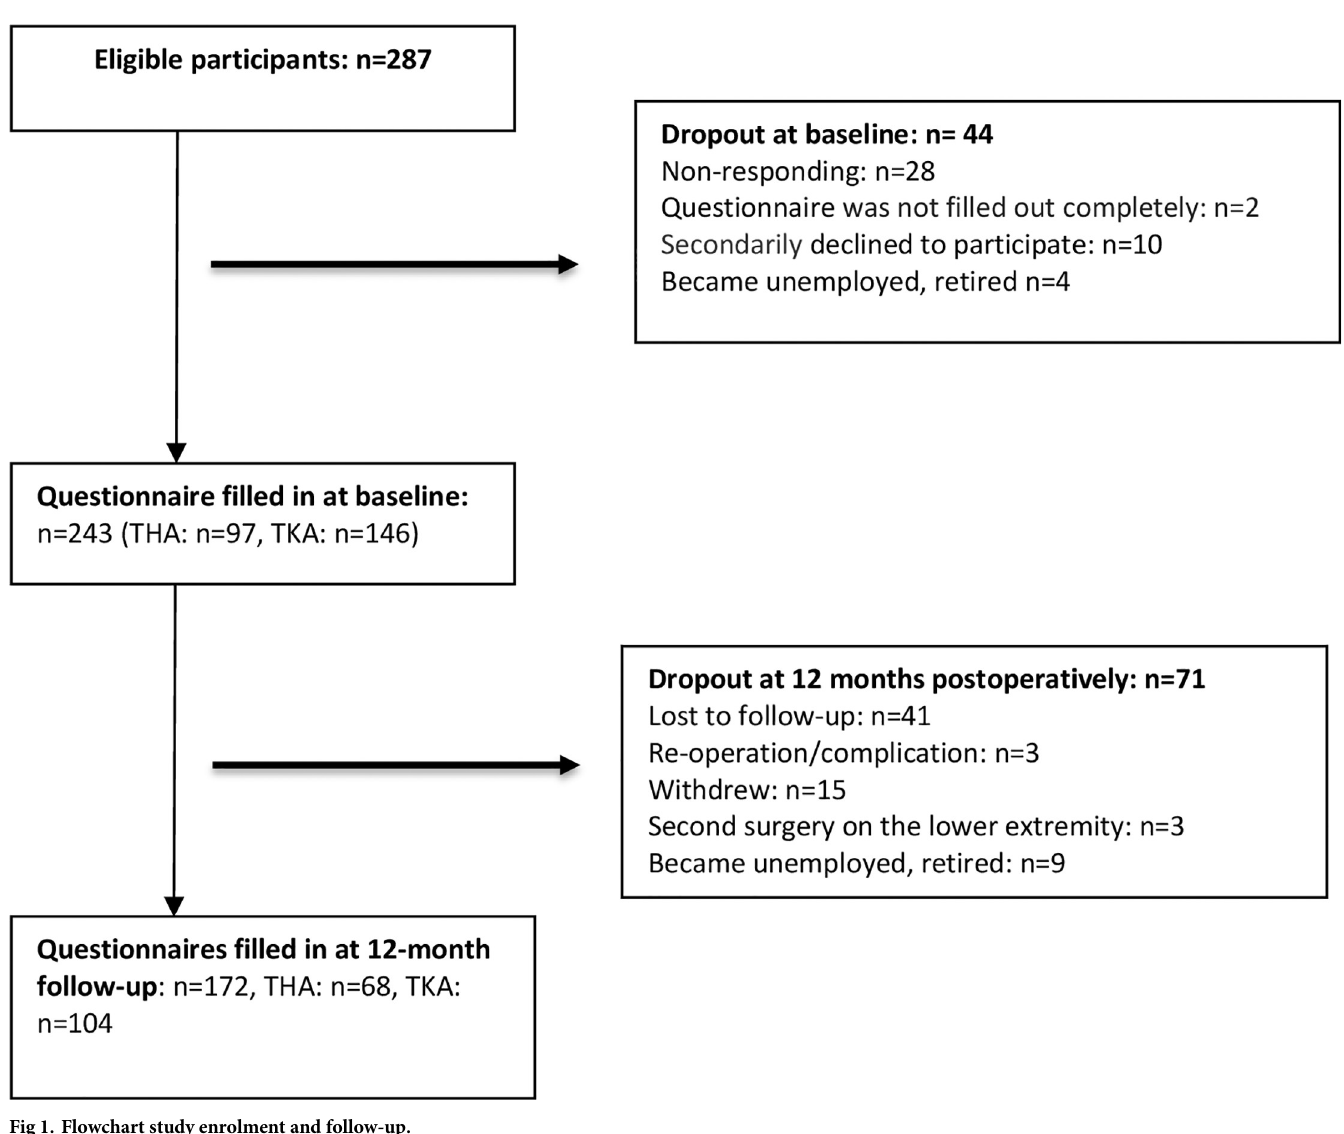
Fig 1. Flowchart study enrolment and